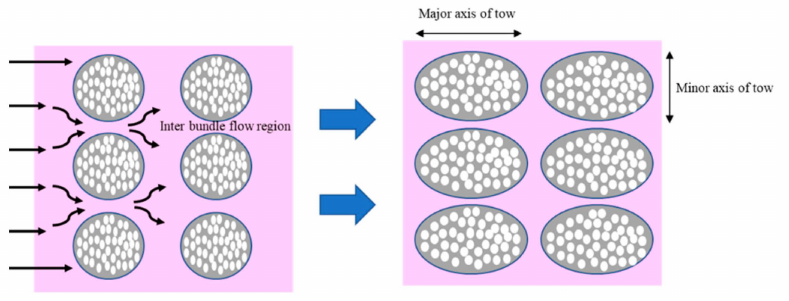
Figure 9. Flow behavior in the double-scale porous